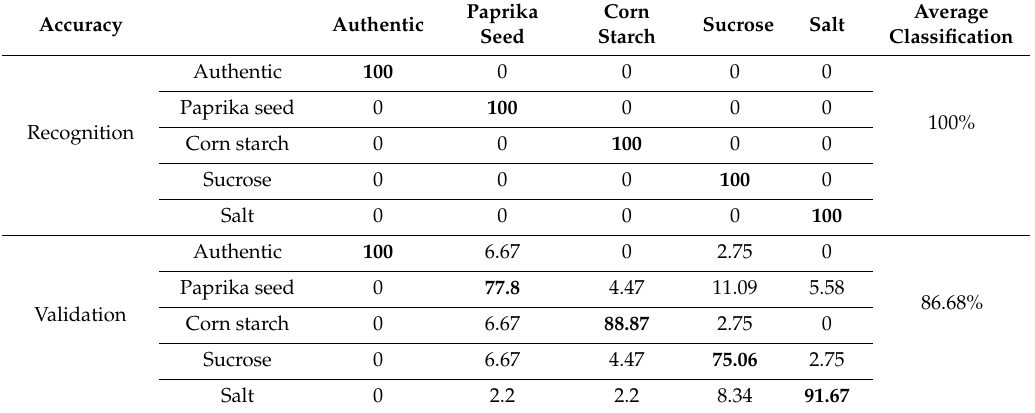
Figure 3. Linear discriminant analysis (LDA) classifications on the whole NIRS dataset (N = 171) in the wavelength range of 950-1650 nm, after SG, MSC pretreatment of the NIRS spectra and three-fold cross-validation: ( a ) LDA plot when the adulterant type was used as class variable (C0–C5 present the adulterant concentration); ( b ) LDA plot when the adulterant concentration was used as class variable. Table 4. Linear discriminant analysis (LDA) classifications on the whole Near Infrared Spectroscopy (NIRS) dataset in the wavelength range of 950–1650 nm, after Savitzky-Golay smoothing (SG) and multiplicative scatter correction (MSC) pretreatments and three-fold cross-validation when the adulterant type was used as class variable.